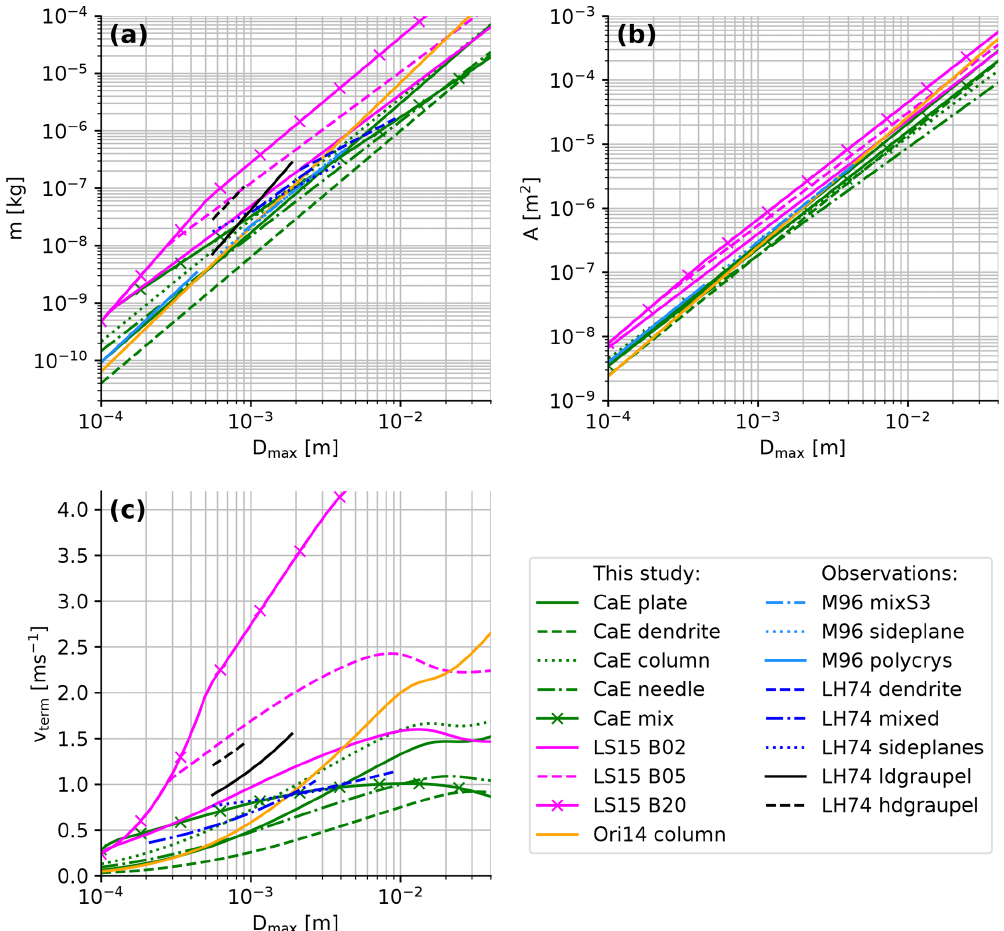
Figure 4. Mass (a) , projected area (b) , and terminal velocity (c) of a selection of the simulated aggregates included in snowScatt and two frequently used in situ studies (Locatelli and Hobbs, 1974; Mitchell, 1996). Terminal fall velocity in (c) is calculated using the hydrodynamic model from Böhm